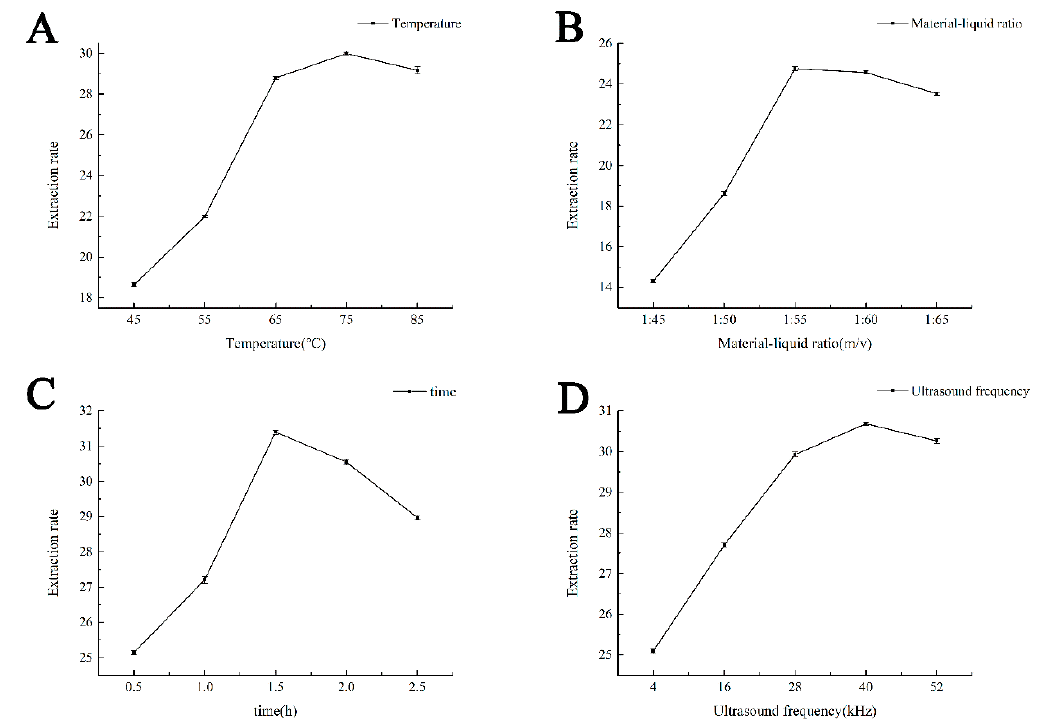
Figure 2. Effects of different extraction parameters on the naringin extraction rate. ( A ) The effect of Figure 2. E ff ects of di ff erent extraction parameters on the naringin extraction rate. ( A ) The e ff ect of extraction temperature on naringin extraction rate; ( B ) The effect of material ratio on the naringin extraction temperature on naringin extraction rate; ( B ) The e ff ect of material ratio on the naringin extraction rate; ( C ) The effect of extraction time on the naringin extraction rate; ( D ) The effect of extraction rate; ( C ) The e ff ect of extraction time on the naringin extraction rate; ( D ) The e ff ect of ultrasonic frequency on the naringin extraction rate. ultrasonic frequency on the naringin extraction rate.